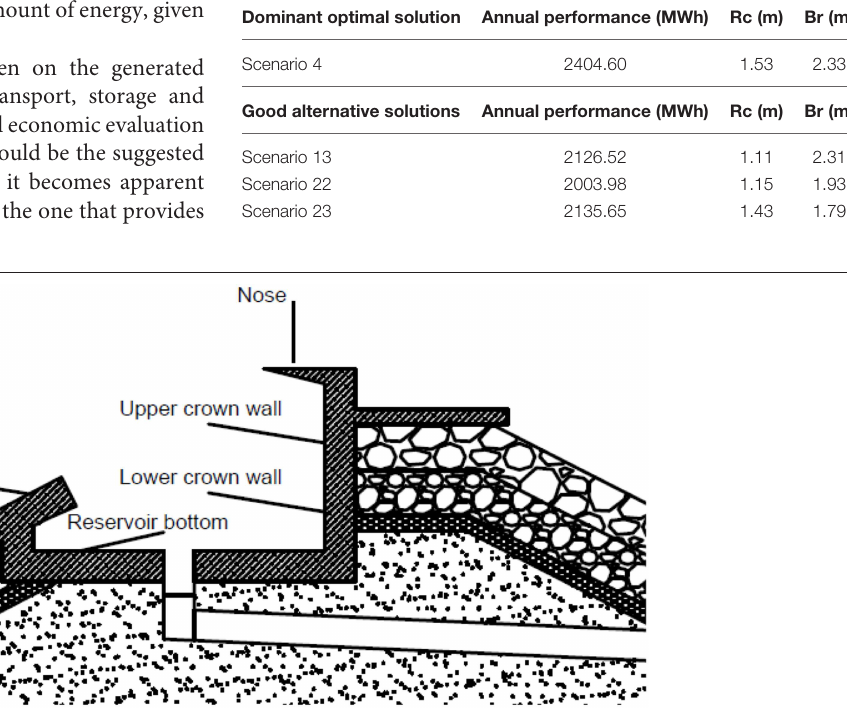
TABLE 4 | Final optimal solutions.